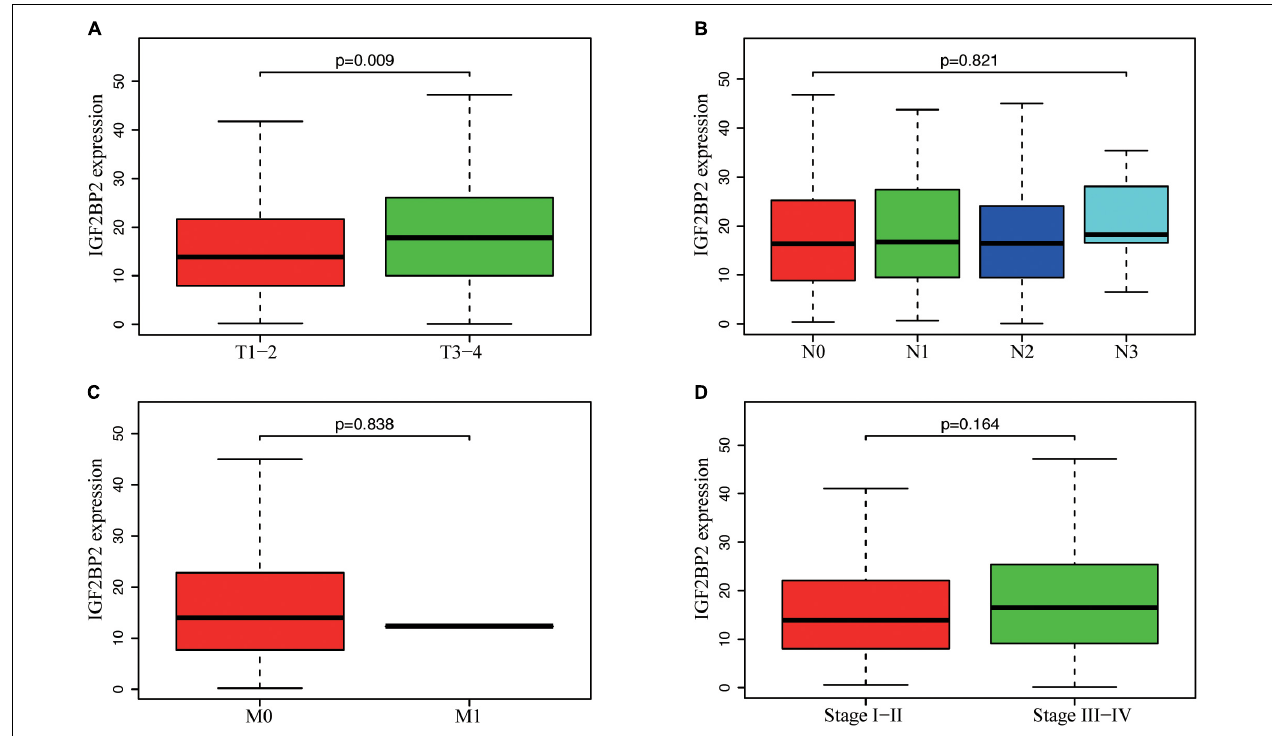
FIGURE 4 | Correlation between IGF2BP2 expression and clinicopathologic characteristics. (A) subgroup analysis of T classification (T1–2 and T3–T4). (B) Subgroup analysis of N classification (N0/N1/N2/N3). (C) Subgroup analysis of M classification (M0 and M1). (D) Subgroup analysis of clinical stage (stage I–II and stage III–IV). Wilcox test in A/C/D, Kruskal test in (B)